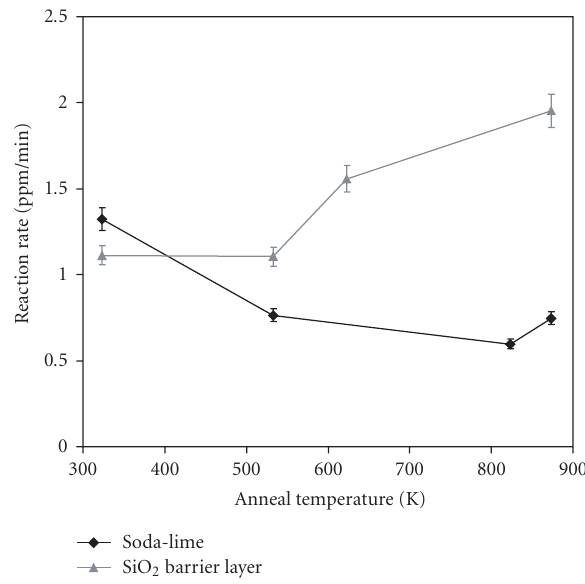
Figure 3: Dependence of the photocatalytic breakdown reaction rate of TiO 2 thin films on the anneal temperature for the two di ff er- ent substrate types. The reaction rate of the photocatalytic break- down of 273 ppm ethanol was determined from the slope of the concentration versus time